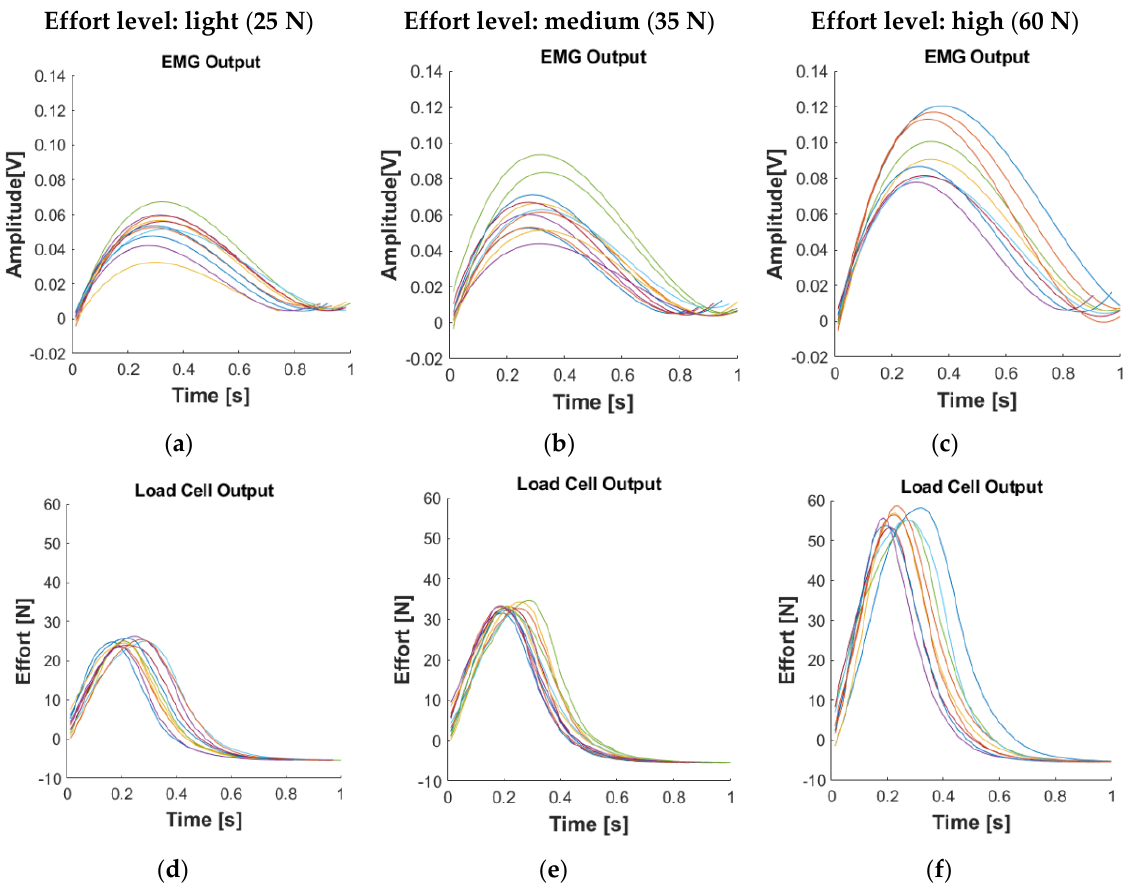
Figure 9. Third movement signals. Model-based EMG signals for the effort level ( a ) light, ( b ) medium, ( c ) high, respectively; load cell output signals for the effort level ( d ) light, ( e ) medium, ( f ) high, respectively.